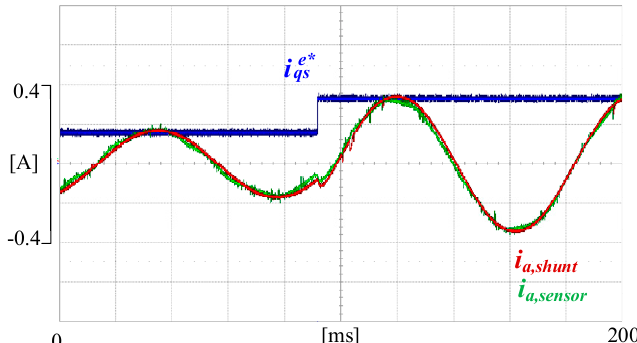
Figure 17. The phase current sampled through shunt resistor when the motor is operated at 30 rpm: ( a ) Conventional voltage injection method; ( b ) proposed intermittent PWM shift method; ( c ) FFT result of the phase current.